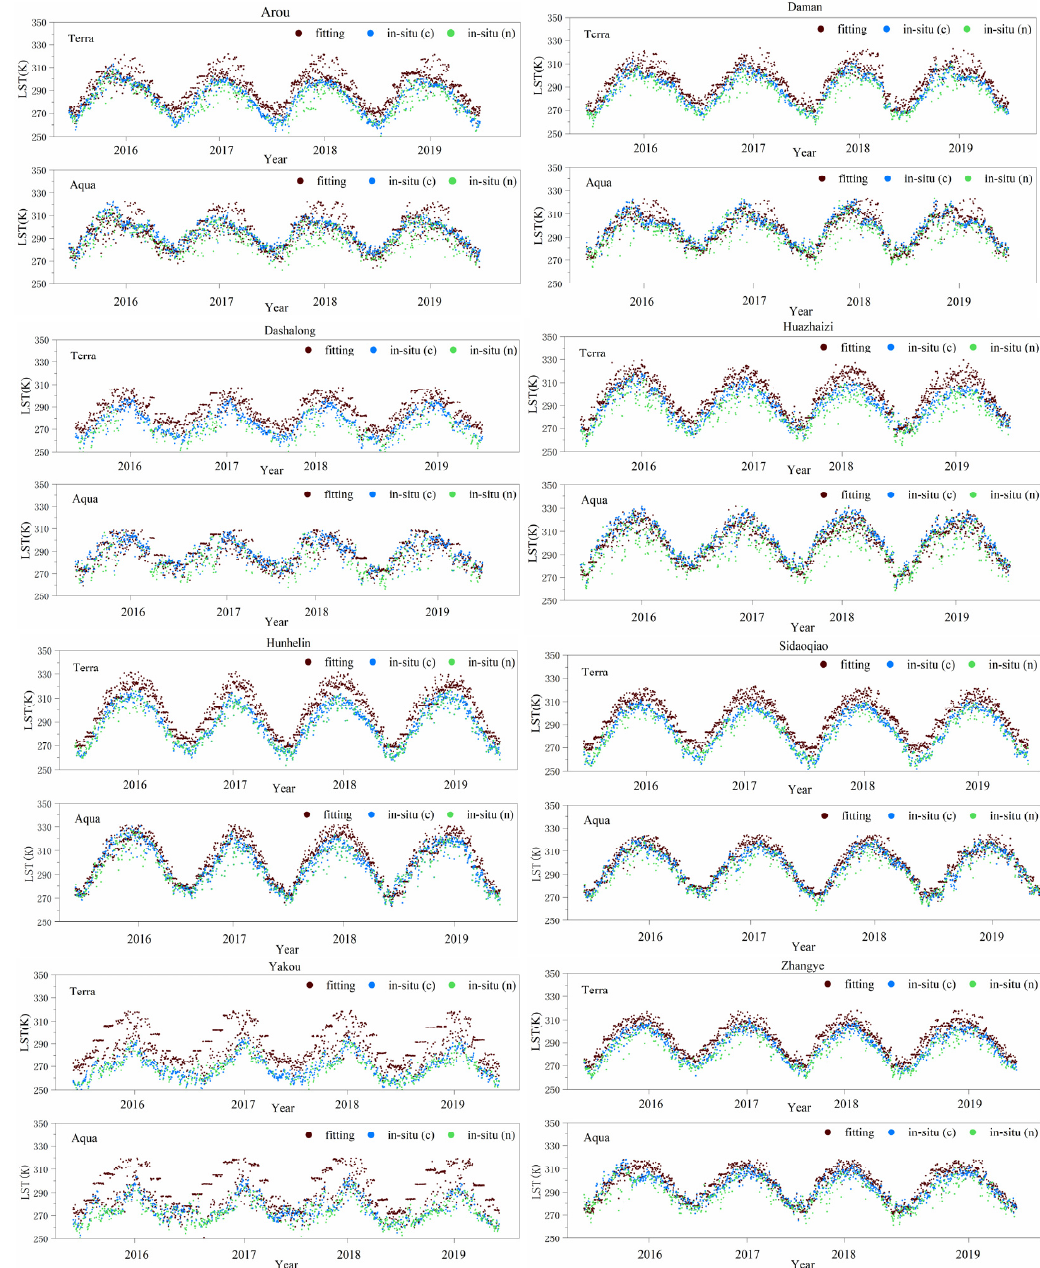
Figure 4. Comparison of reconstructed LST using the spatial method with LST measured by AWS at 8 sites from 2016 to 2019. in situ (n) indicates the measured LST with cloudy skies at the observation station; in situ (c) indicates the measured LST with clear skies at the observation station.